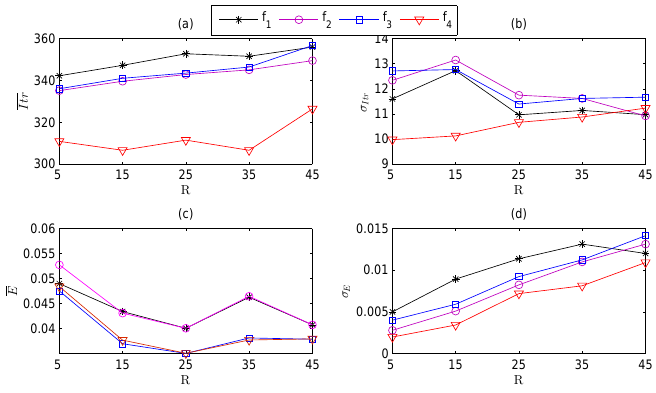
Figure 2. Localization performance of different f using WPSO with global-best model.( a ) Itr ; ( b ) σ Itr ; ( c ) E ; ( d ) σ E